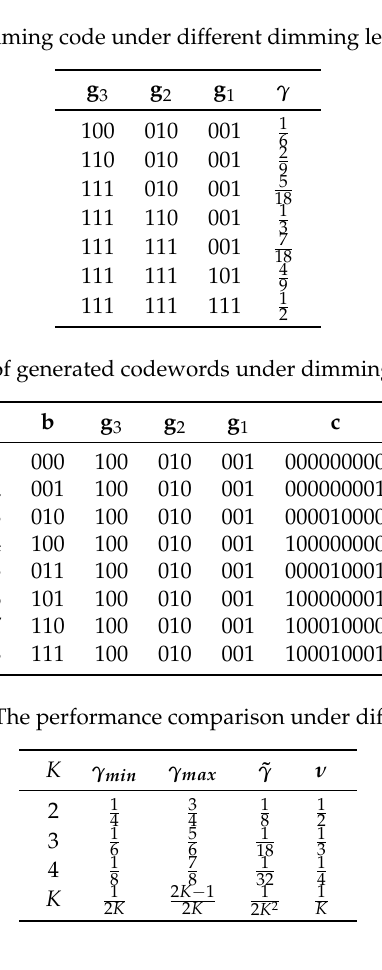
Table 1. The dimming code under different dimming levels with K = 3.